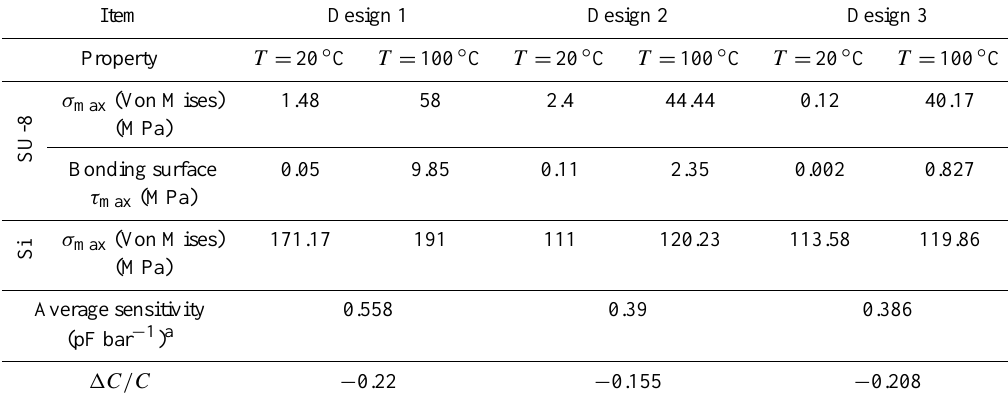
Table 2. A summarized comparison of the three capacitive pressure sensor designs.